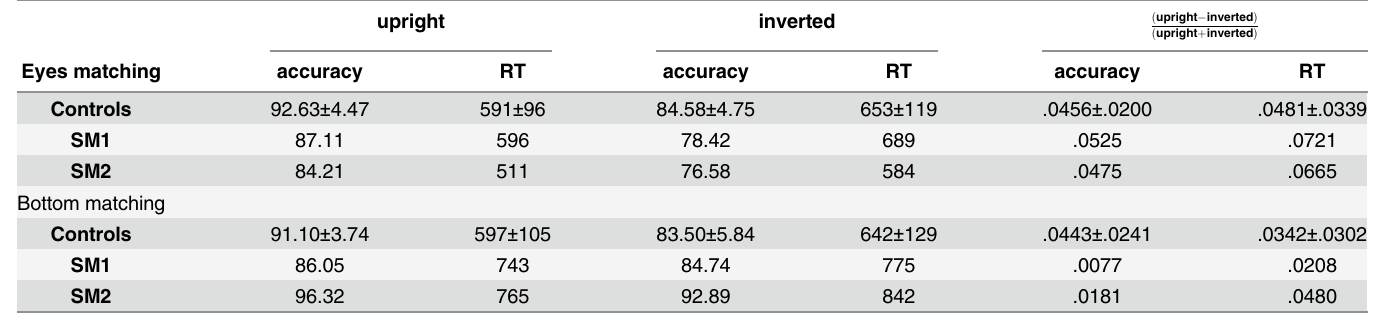
Table 5. Results for Experiment 5: Face inversion effect.